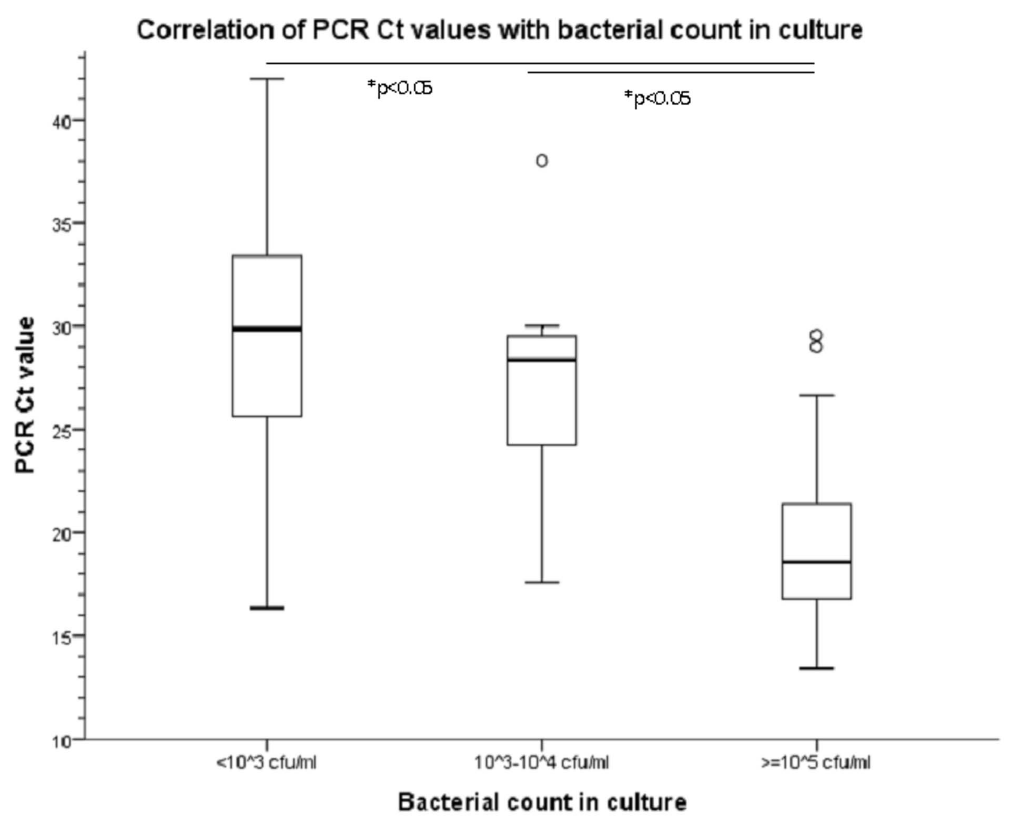
Figure 3. Boxplot showing the correlation of PCR Ct values with bacterial load determined in culture. Culture results were grouped into three categories: , 10 3 CFU/ml, 10 3 –10 4 CFU/ml and $ 10 5 CFU/ml. Statistical significance was determined performing Kruskal-Wallis Test.